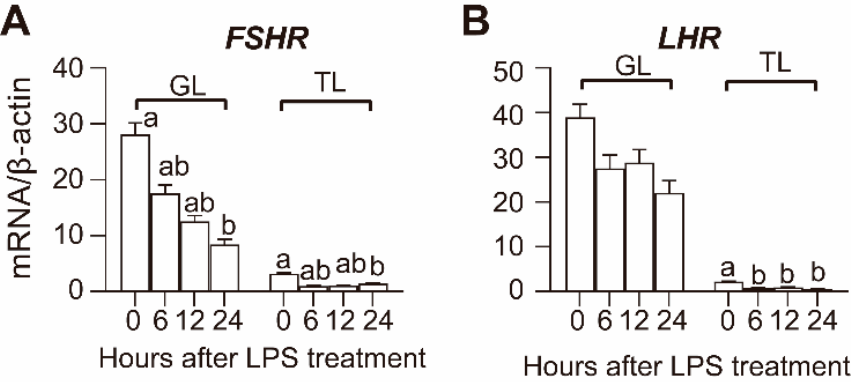
Figure 3. Effect of LPS on FSHR ( A ) and LHR ( B ) mRNA expression in hierarchical follicles. GL, granulosa layer; TL, theca layer. Values with different letters are significantly different ( p < 0.05).